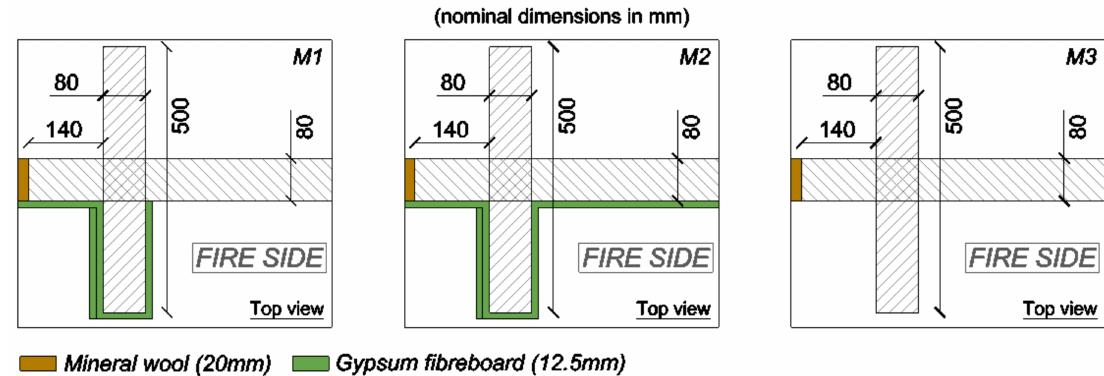
Figure 12. Reference thermal boundary conditions for the M1-to-M3 parametric numerical models, by changing the layout of the insulation layers (top view detail of the corner joint